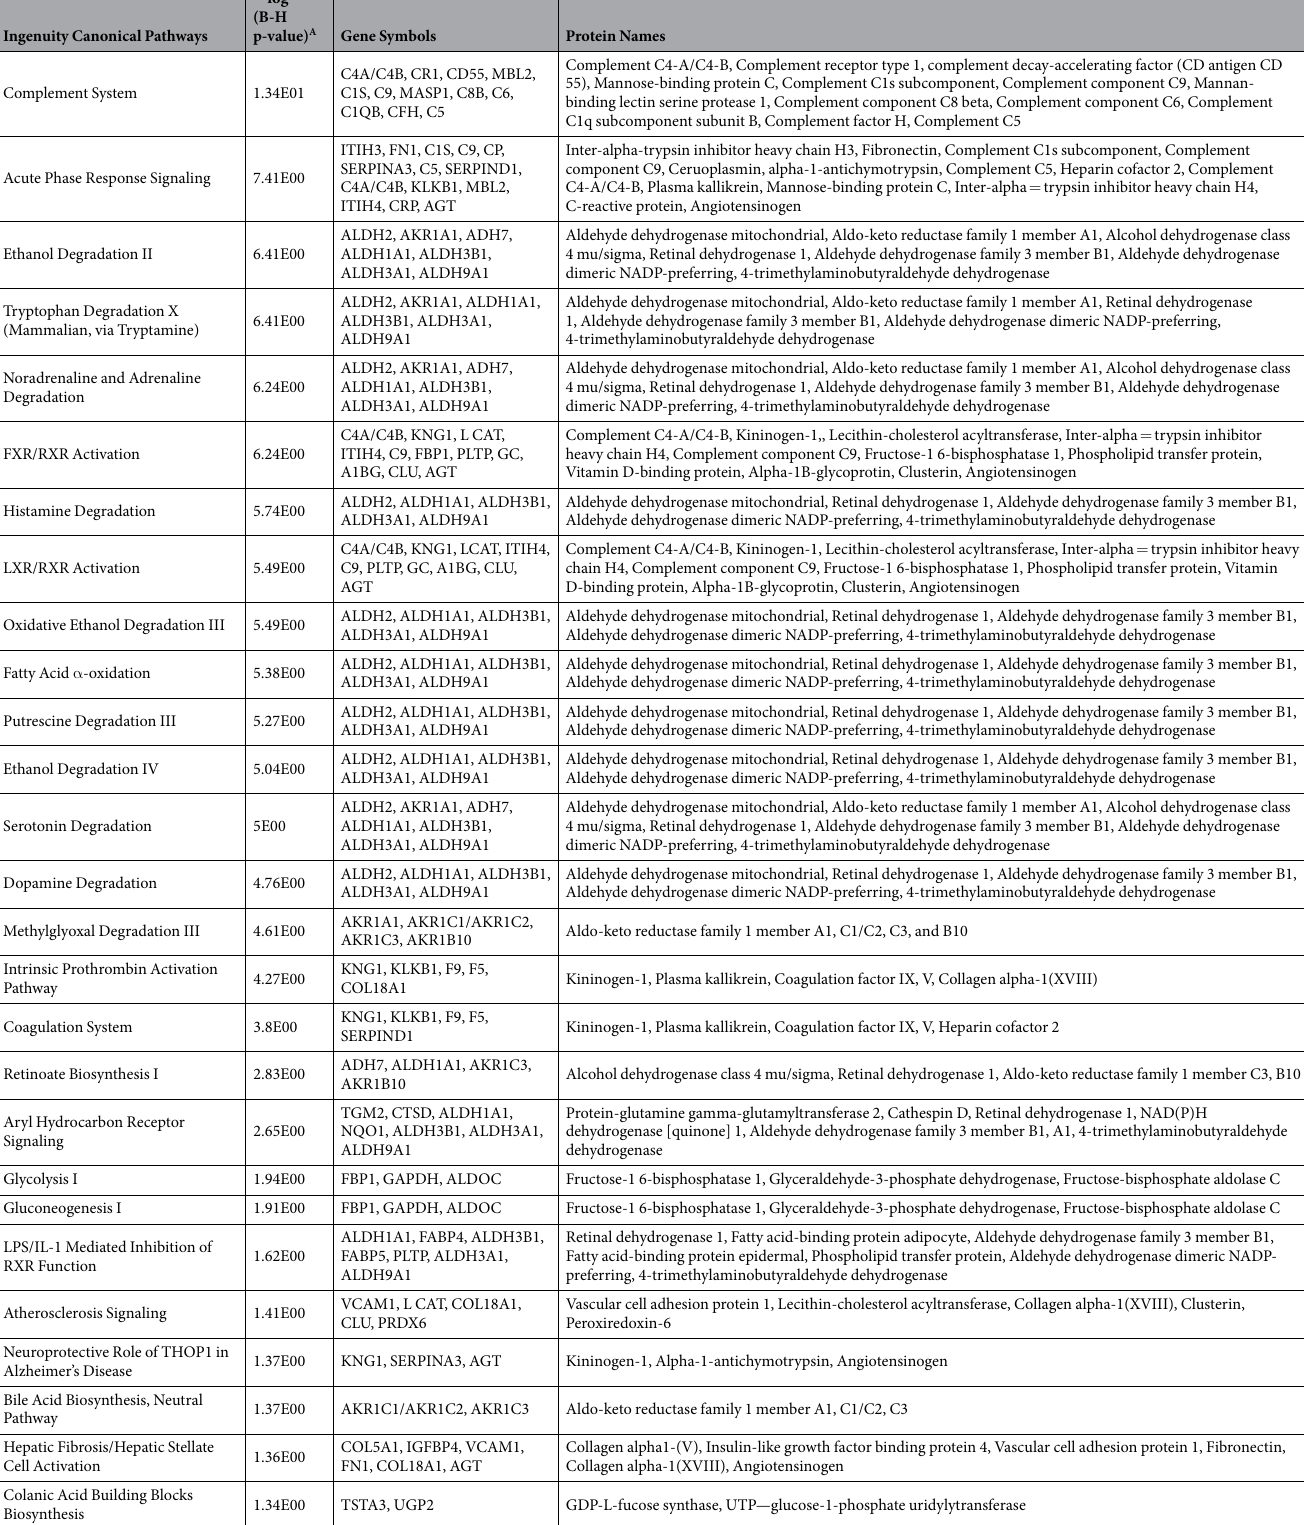
Table 5. IPA Canonical Pathways Represented by Proteins Differentially Expressed Between Survivors and Non-Survivors. A Threshold for significance is -log (B-H) p-value ≥ 1.3, which is equivalent to a corrected p-value ≤